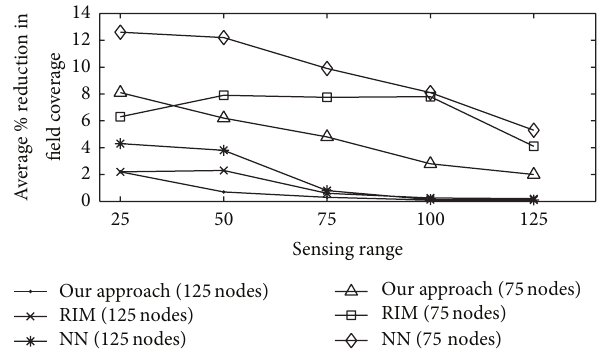
Figure 6: Total number of nodes moved versus communication range (meters) for 25 to 125 nodes in the network.